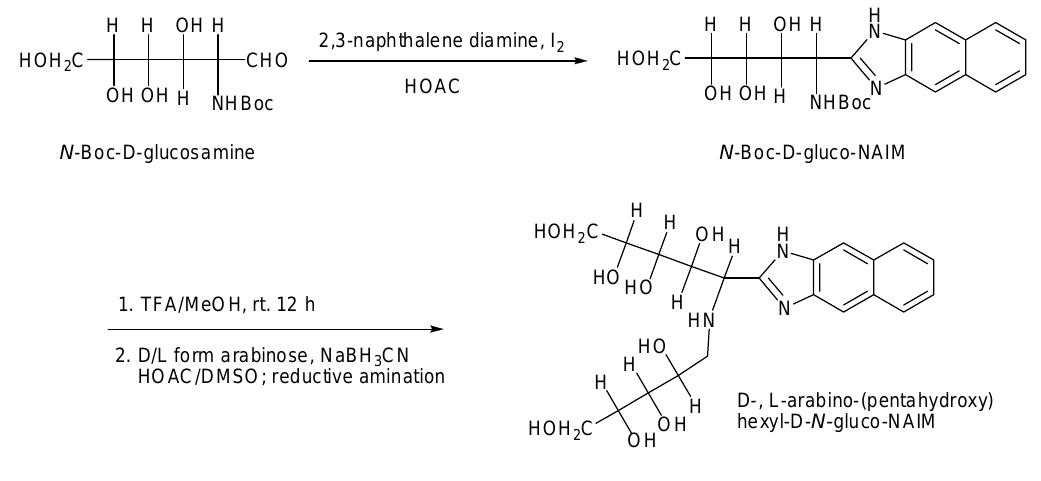
PO , 300 mM, pH 3.0, 2 4